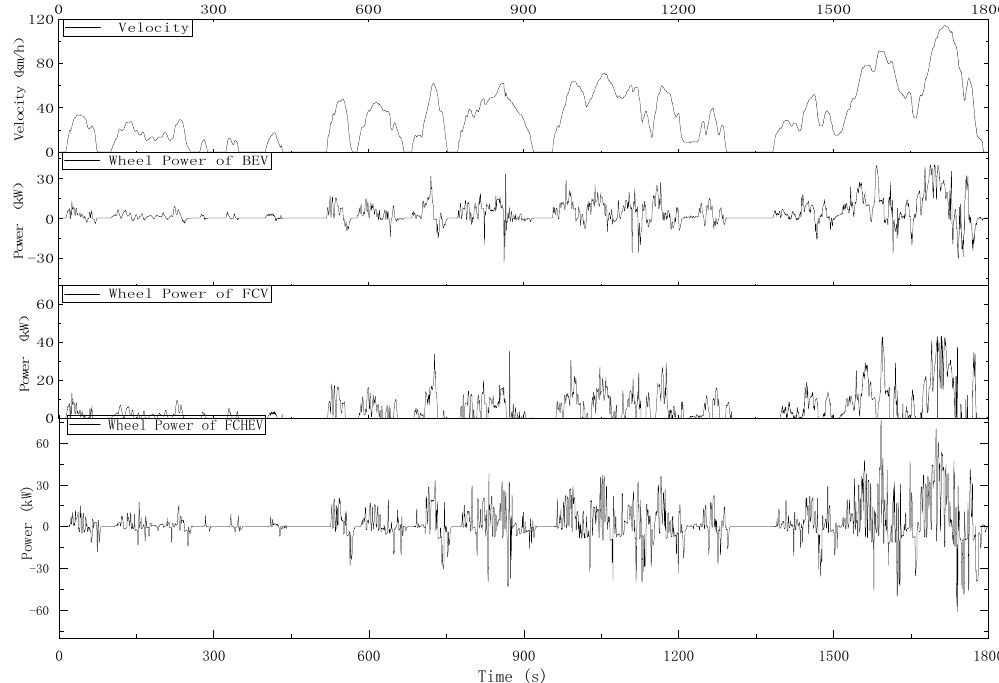
Figure 5. Changes in power of three models under CLTC-P (China light-duty vehicle test cycle-passenger car).